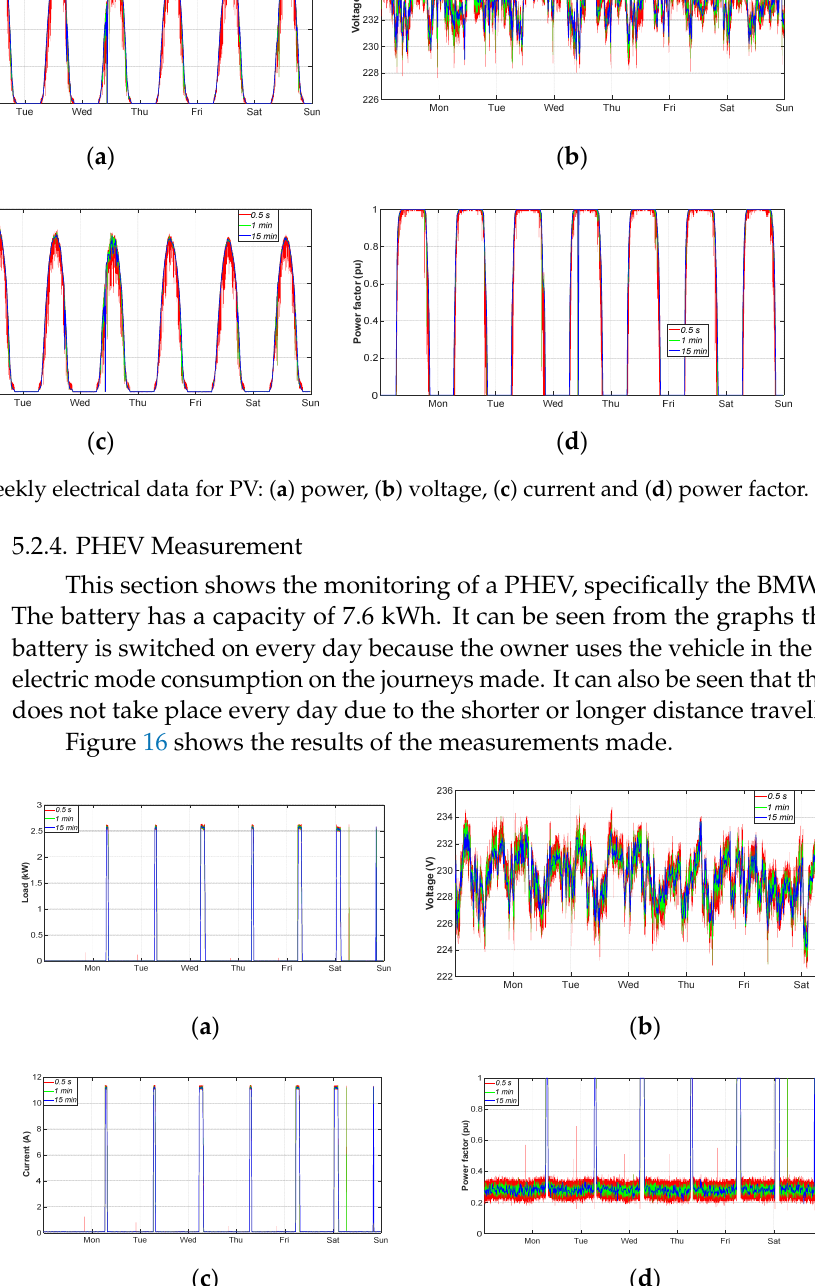
Figure 16. Weekly electrical data for PHEV: ( a ) power, ( b ) voltage, ( c ) current and ( d ) power factor.